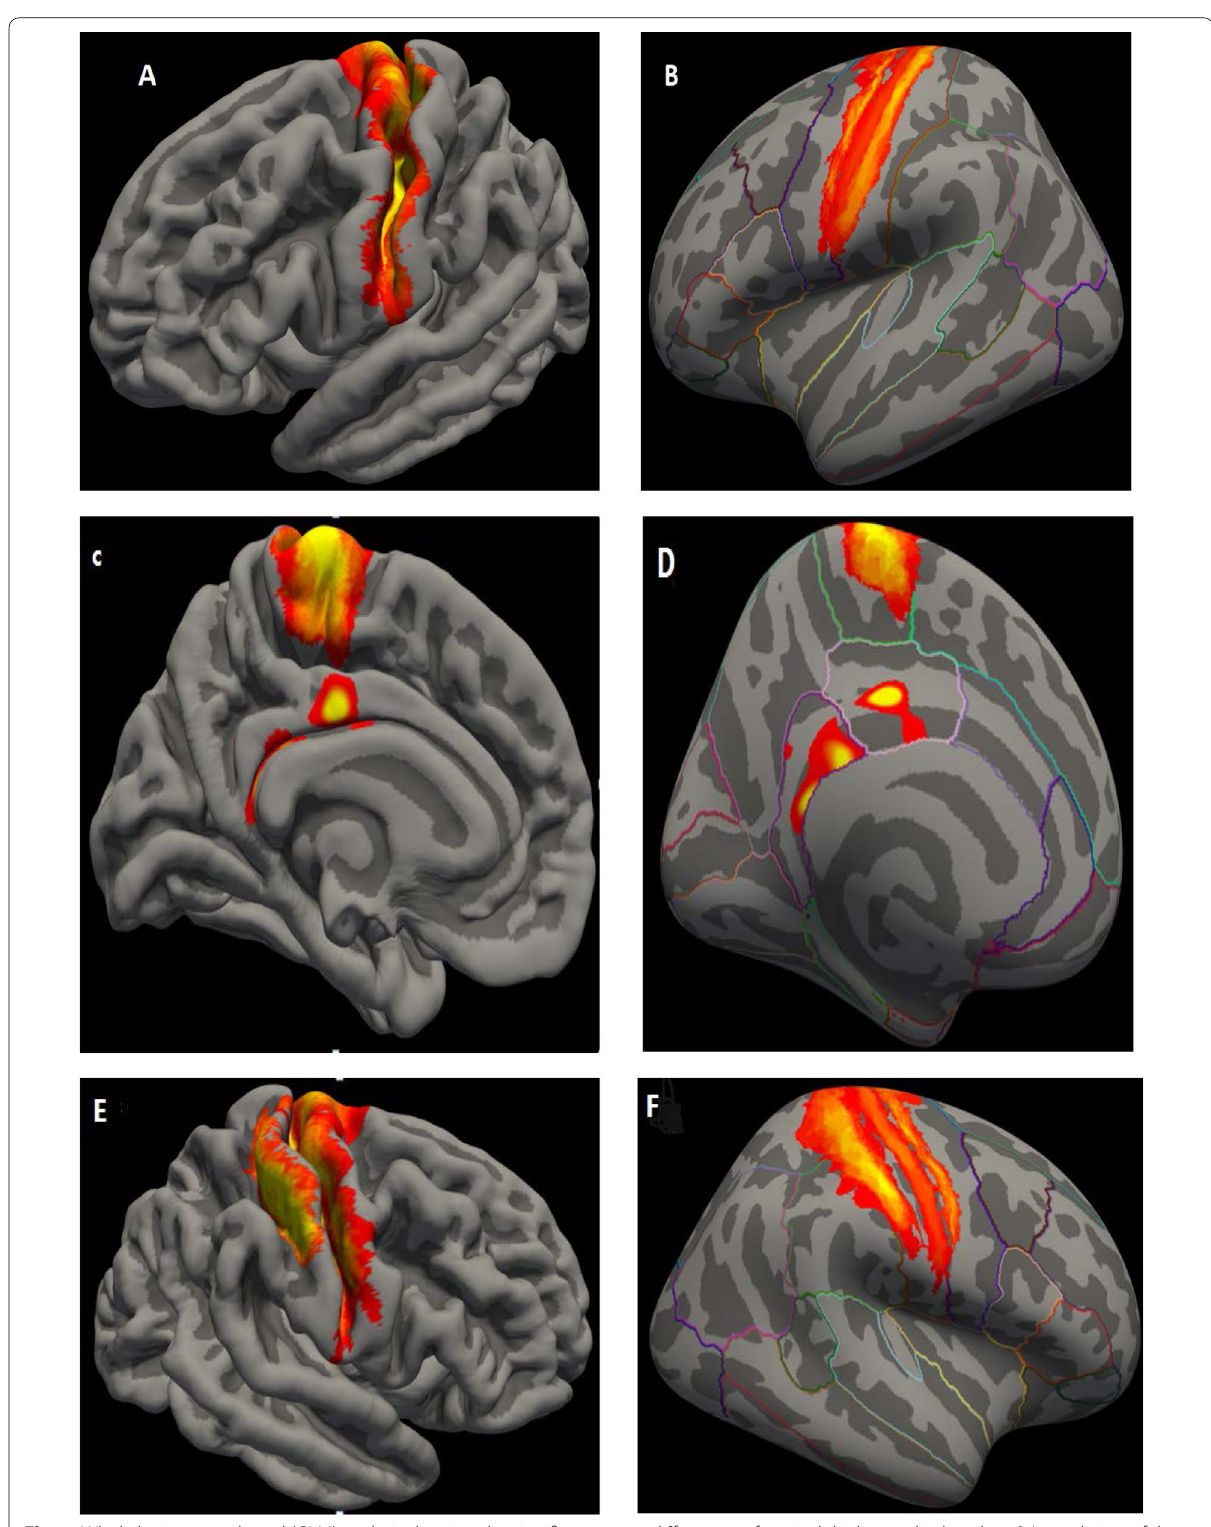
Fig. 1 Whole brain vertex-based (GLM) analysis showing the significant group differences of cortical thickness, displayed on A Lateral view of the left hemisphere surface template, B inflated view. The highlighted areas are precentral and postcentral cortex. C Medial view of the left hemisphere surface template, D inflated view. The highlighted areas are paracentral lobule and posterior cingulate cortex. E Lateral view of the right hemisphere surface template, F inflated view. The highlighted areas are precentral and postcentral cortex. G Medial view of the right hemisphere surface template, H inflated view. The highlighted areas are paracentral lobule and posterior cingulate cortex. Significance was set to a P value of <